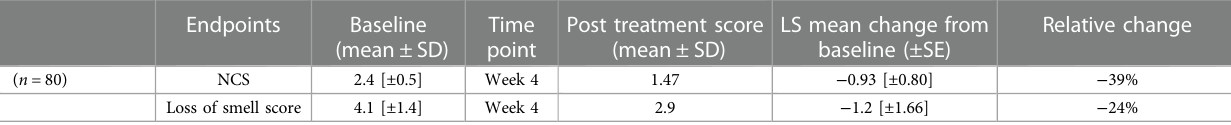
Table adapted from Miglani et al. (74). — , comparisons were unable to be made due to unavailable data; ESS, Endoscopic sinus surgery; Dupi-24, Dupilumab Liberty NP SINUS-24; Dupi-52, Dupilumab